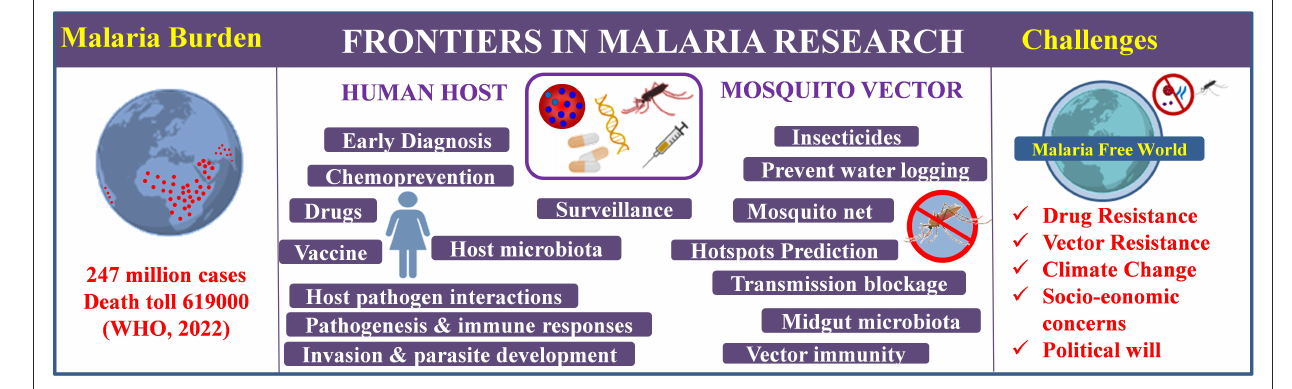
FIGURE1 Schematic representation of global malaria burden, research frontiers and future challenges (WHO,